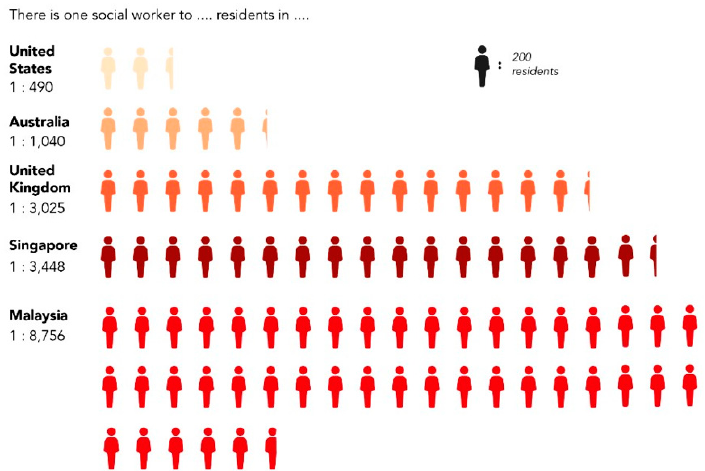
Figure 3. New Bill granting social workers professional status set for Dec tabling, Malay Mail Online, 2020.